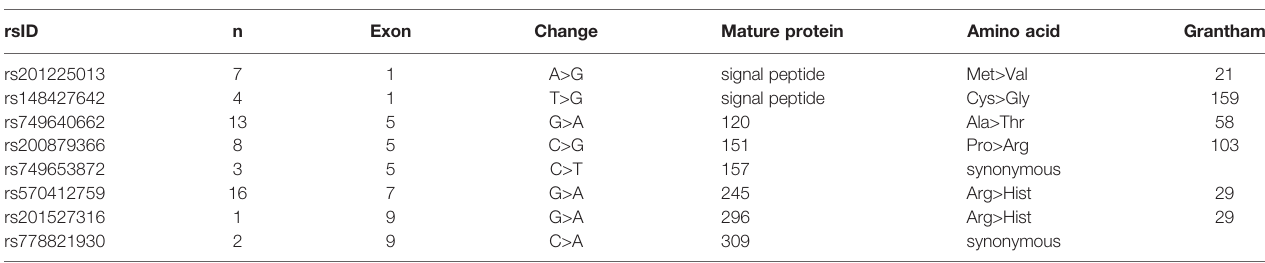
TABLE 3 | Eight con fi rmed novel single nucleotide variants in KIR2DL1 . rsID